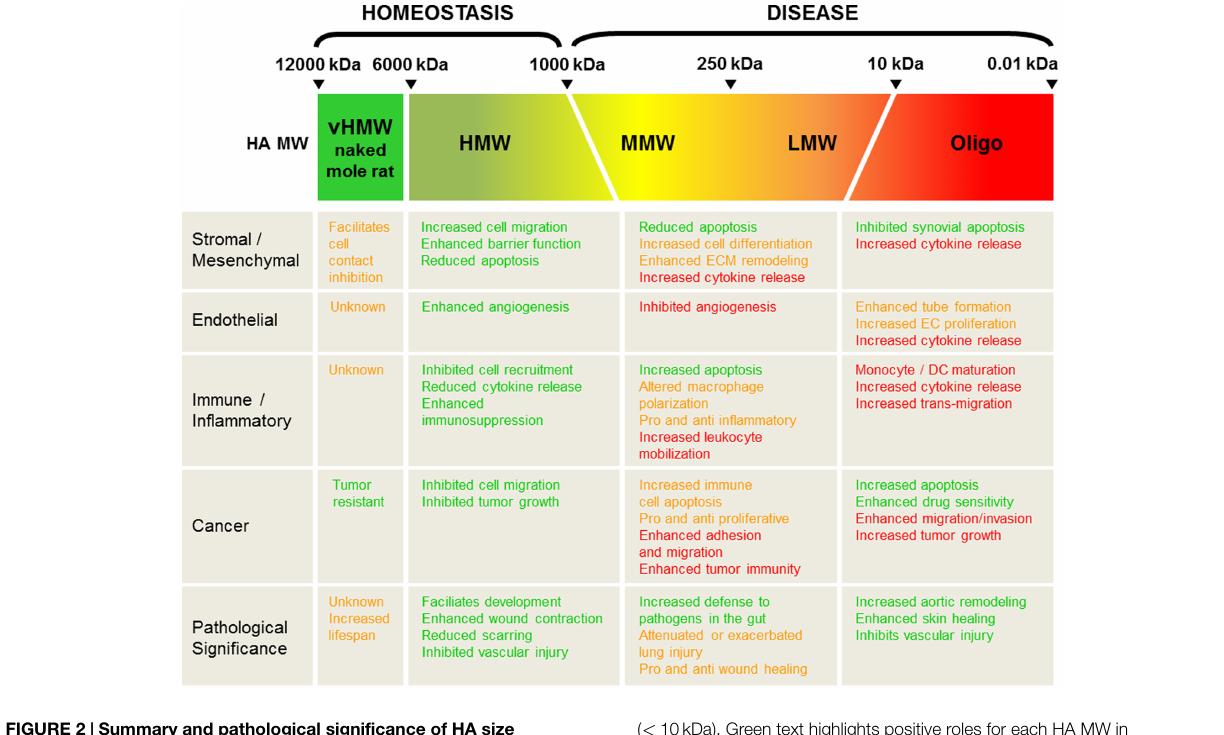
( < 10kDa). Green text highlights positive roles for each HA MW in tissue function and recovery, whereas red text favors pathological decline. Opposing and/or unclear tissue responses are designated in orange-colored